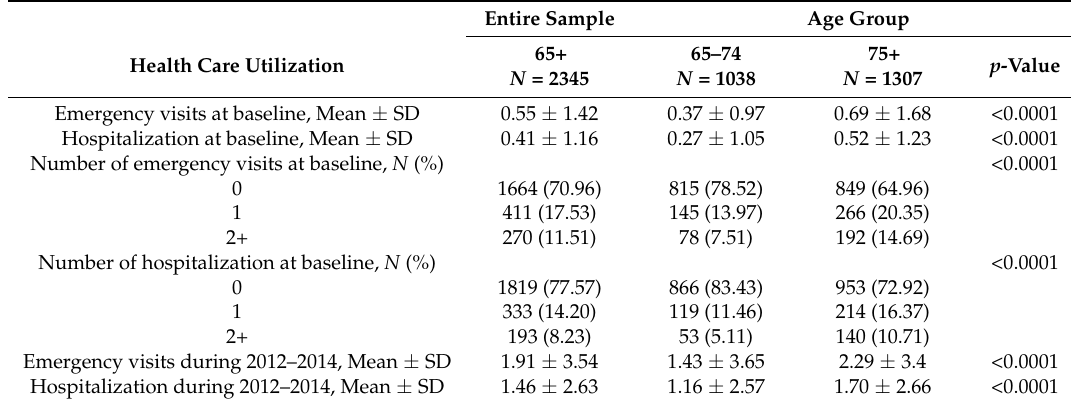
Table 2. Differences in emergency visits and hospitalization by age group.